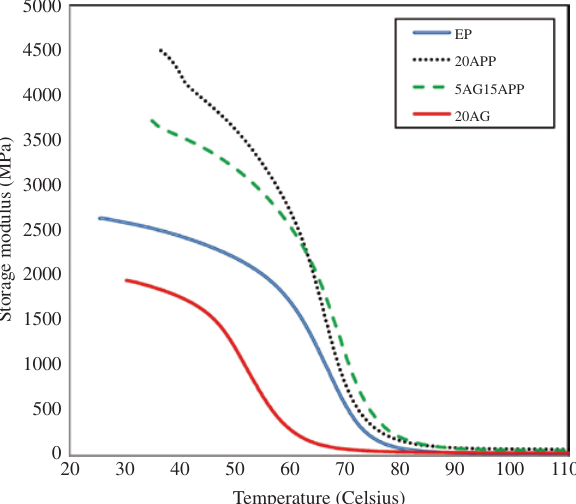
Figure 5: Temperature-dependent storage modulus for different